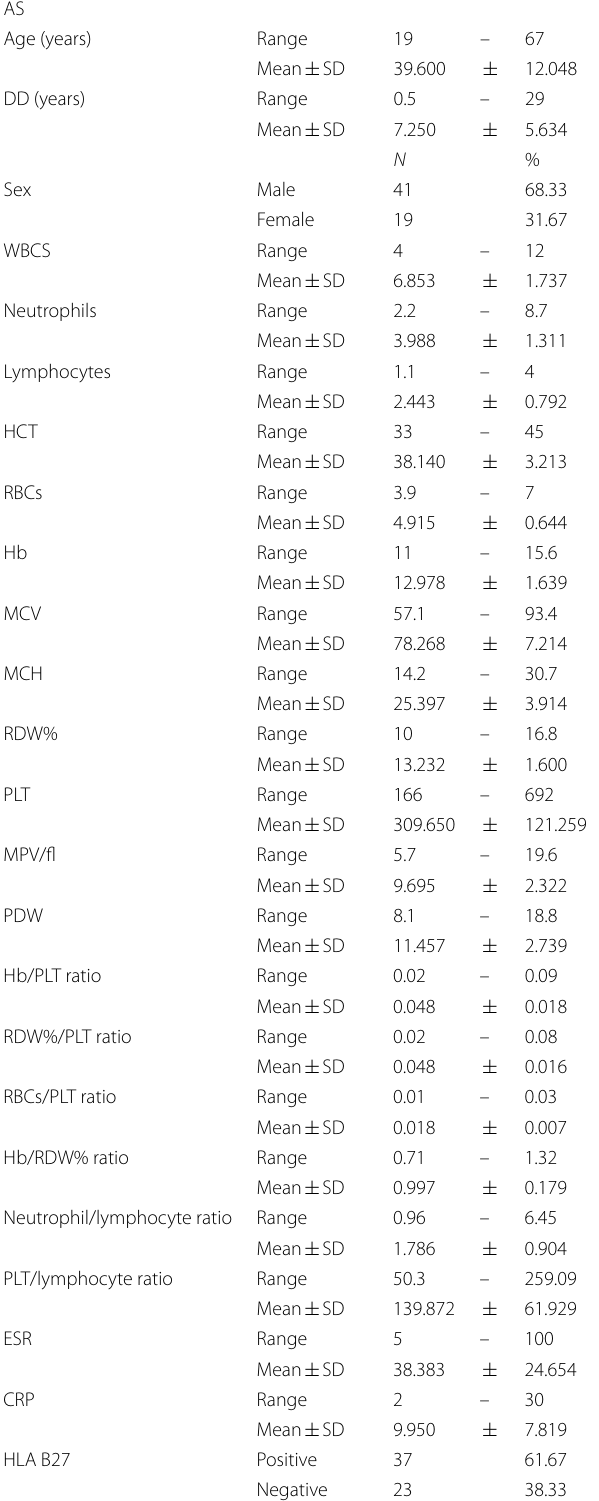
Table 2 Descriptive data of AS patients